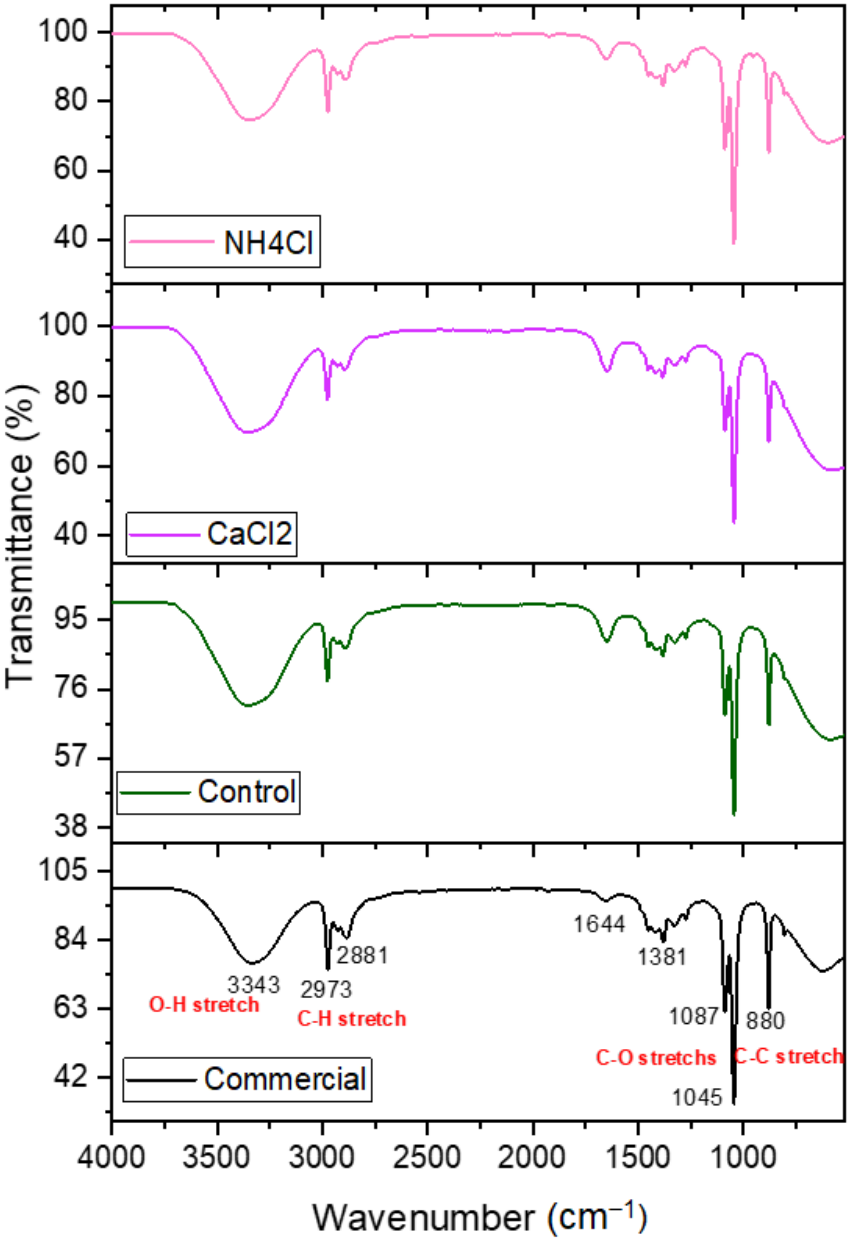
Figure 7. Infrared spectra of the pure commercial ethanol, the control, and the optimal bioethanol products.